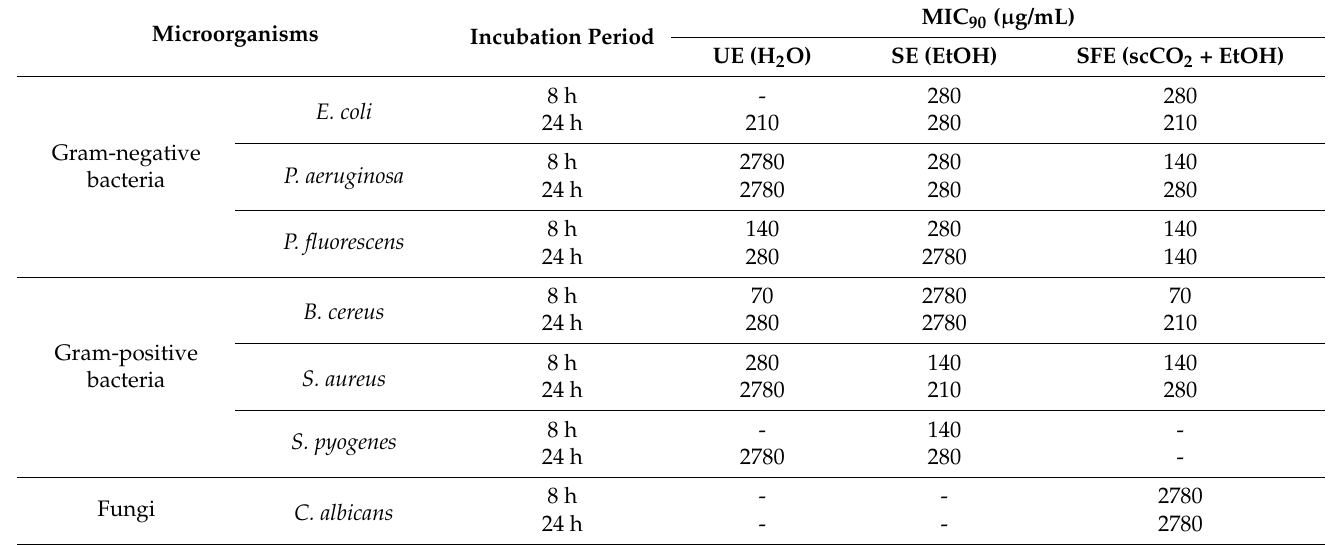
Table 5. Minimum inhibitory concentrations (MIC 90 ) for AS extracts obtained by ultrasonic extraction (UE; solvent H 2 O), Soxhlet extraction (SE; solvent EtOH), and supercritical fluid extraction (SFE; solvent scCO 2 , co-solvent EtOH) on various